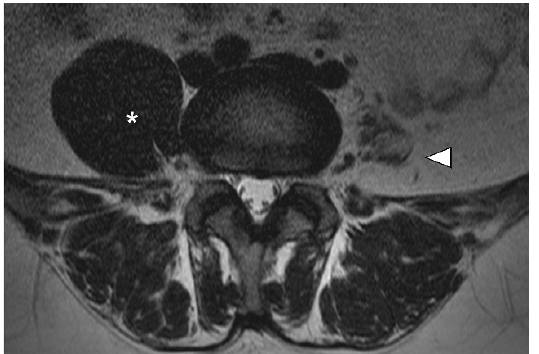
Figure 1. Magnetic resonance imaging (MRI) of the lumbar region. Left iliopsoas muscle atrophy (white arrowhead) compared to the right side (star point) observed on lumbar MRI at the time of the initial visit.